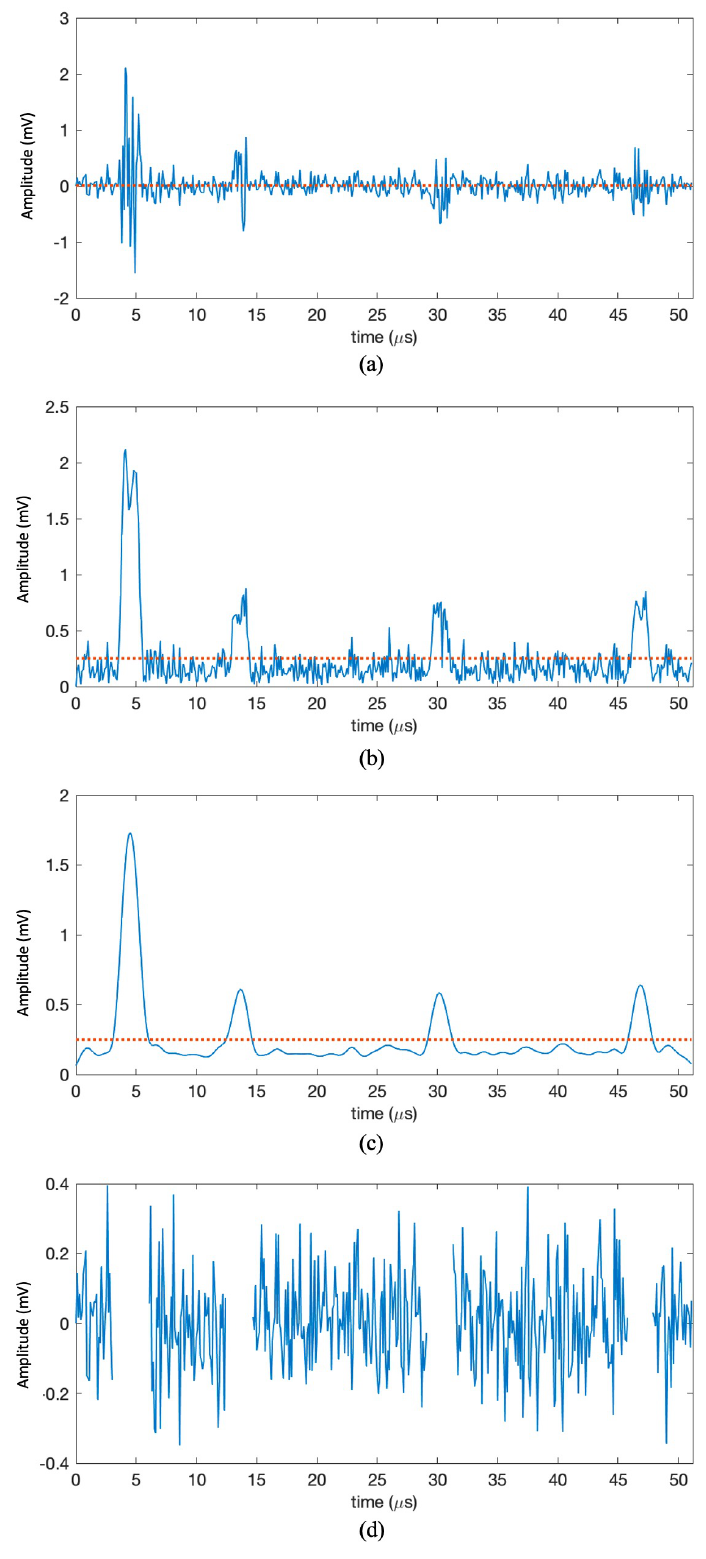
Figure 3. In the presence of interference ( label inter = 1 ) : ( a ) the real part of the received signal; ( b ) the amplitude of the received signal; ( c ) the interference envelope detected by LPF; and ( d ) the received signal containing the affected samples. The dashed line in the subplots indicates the mean value of the corresponding